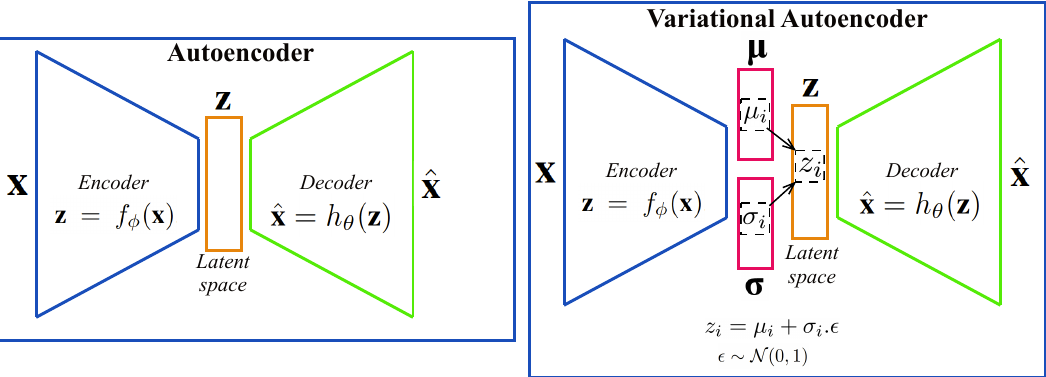
Figure 1. Schematic architecture of a standard deep autoencoder and a variational deep autoencoder. Both architectures have two parts: an encoder and a